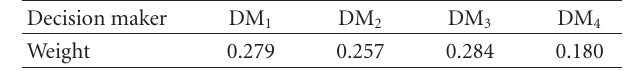
Table 10: Weights of each decision